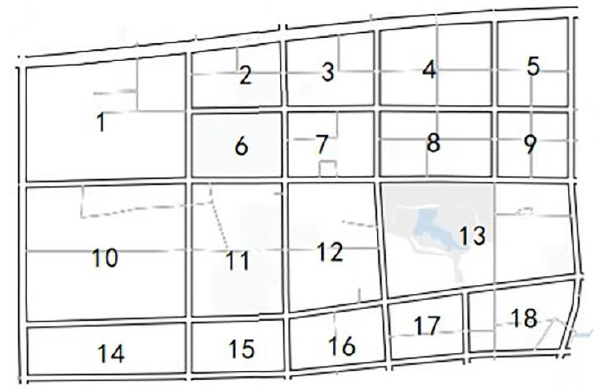
Figure 2. Location and number of each area.